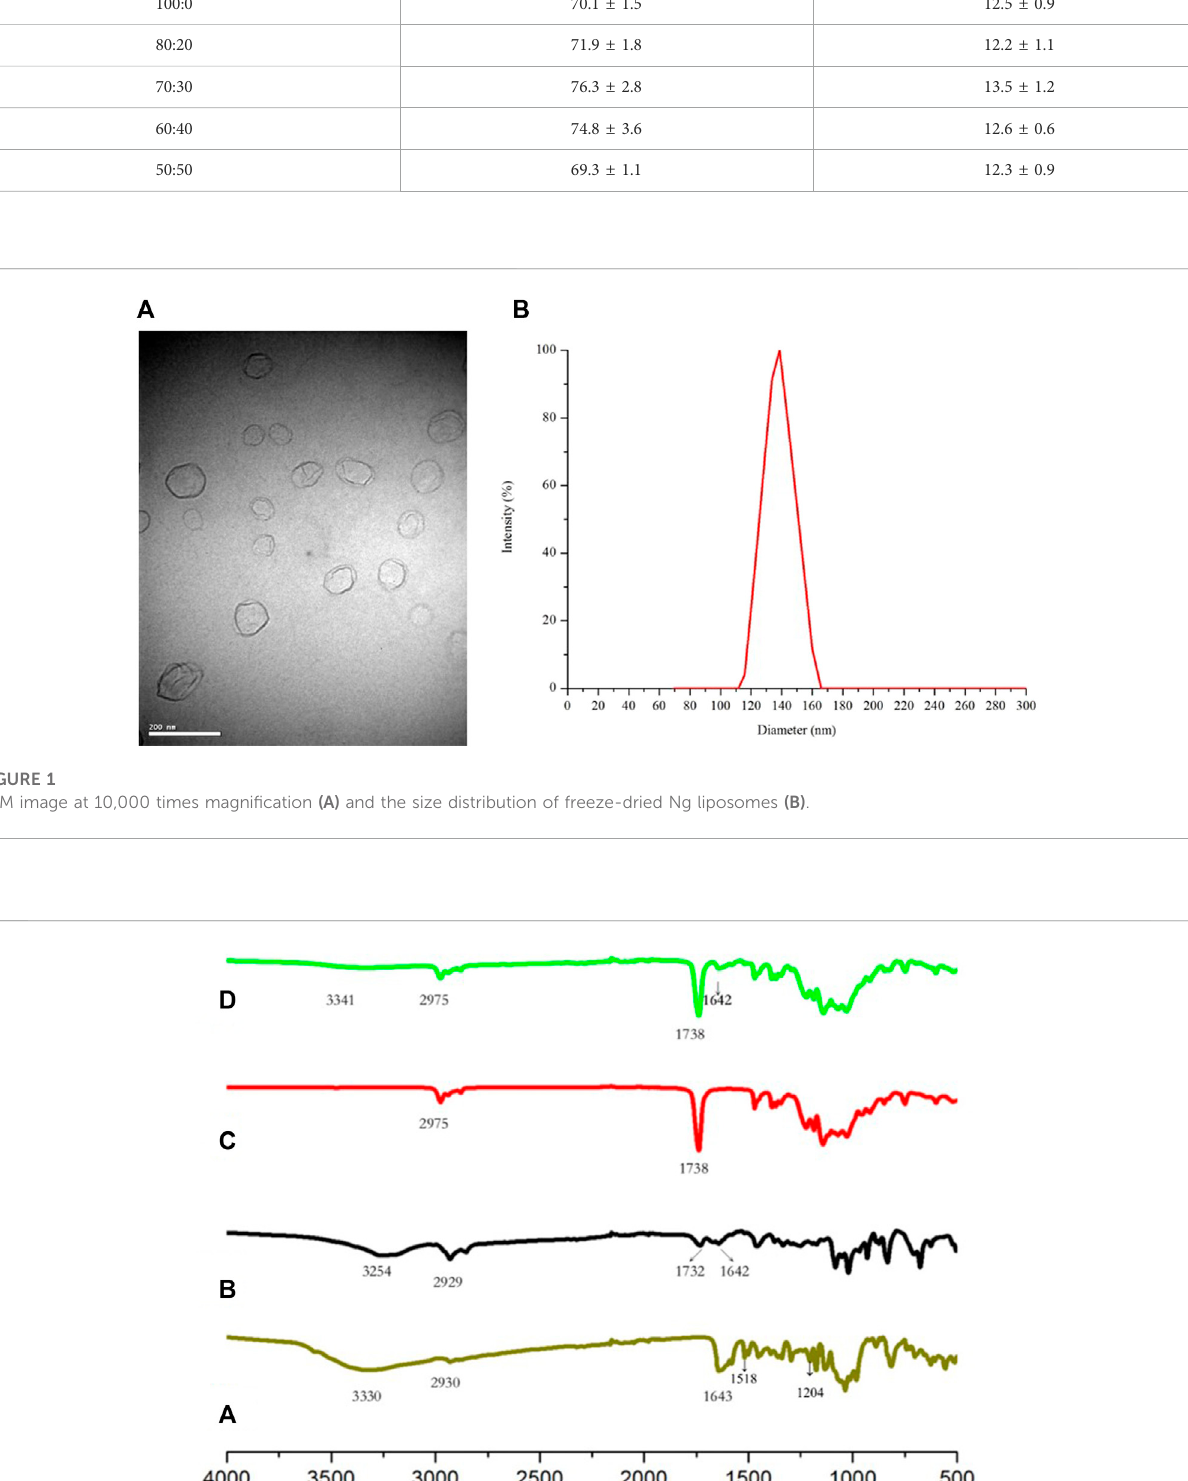
TABLE 1 Encapsulation ef fi cacy of freeze-dried Ng liposomes with different cholesterol concentrations. ( n = 6). Formulation (lipid/cholesterol, mol/mol)